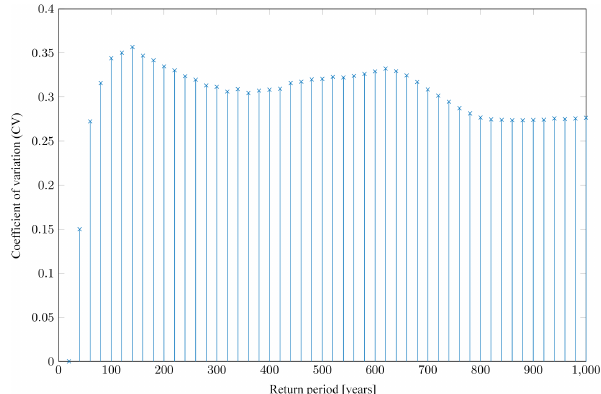
Figure 5. Coefficient of variation (CV) of ground motion predicted to be exceeded at various return periods for the Jambi province (see Fig. 3). The CV remains quite stable over a large range of return